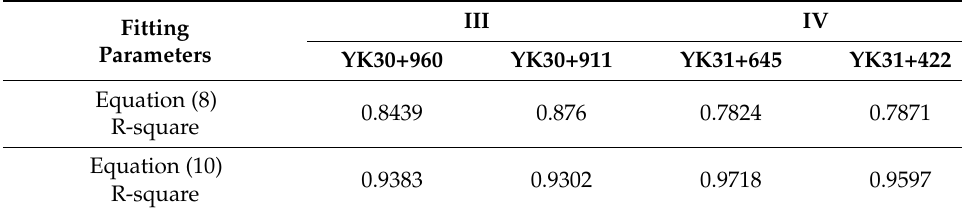
Table 4. Fitting parameters of surrounding rock.